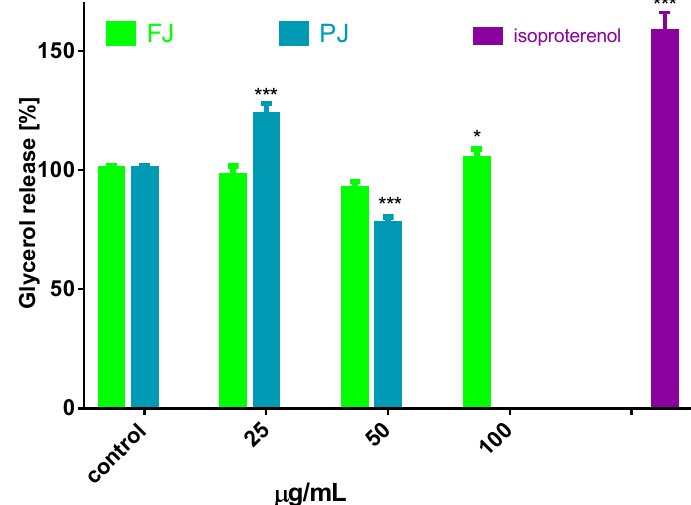
Figure 6. Lipolytic activity of V. opulus FJ and PJ preparations on differentiated 3T3L1; as a positive control 10 µM isoproterenol was used; control cells were not exposed to any compound; values are means ± standard deviations, n = 6; statistical significance was calculated versus control cells * p ≤ 0.05, *** p ≤ 0.001.